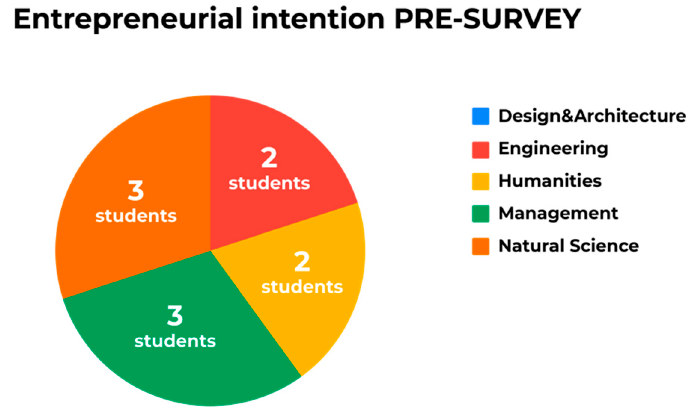
Figure 4. Pre-course EI composition (number of students).